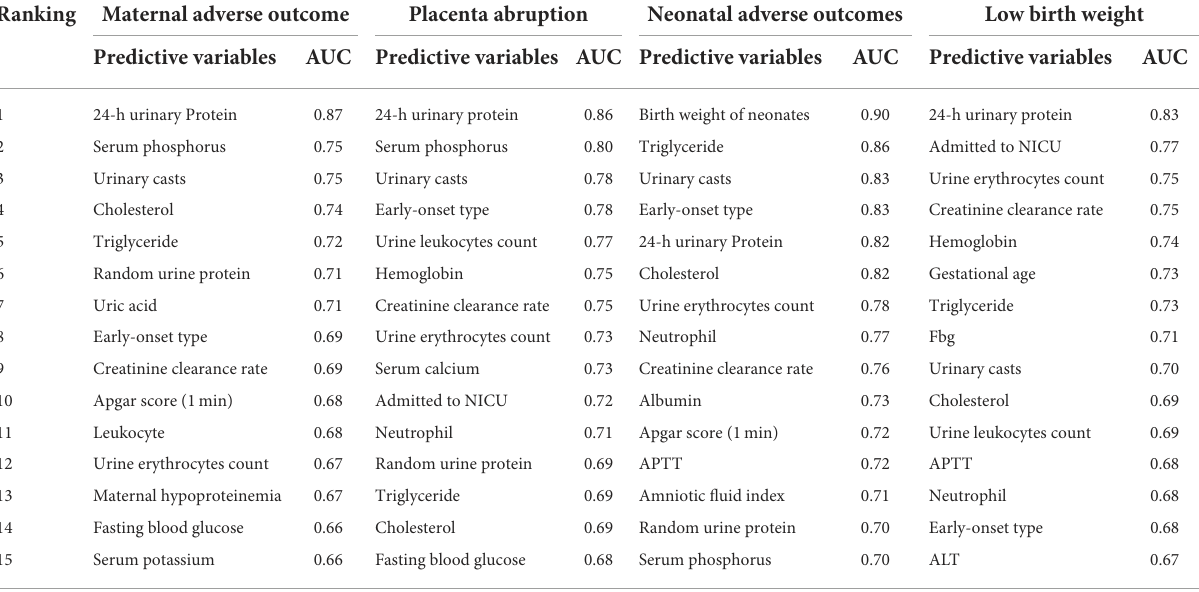
TABLE 3 The AUC, sensitivity, specificity, PPV, and NPV of different predictive models for adverse maternal outcomes.